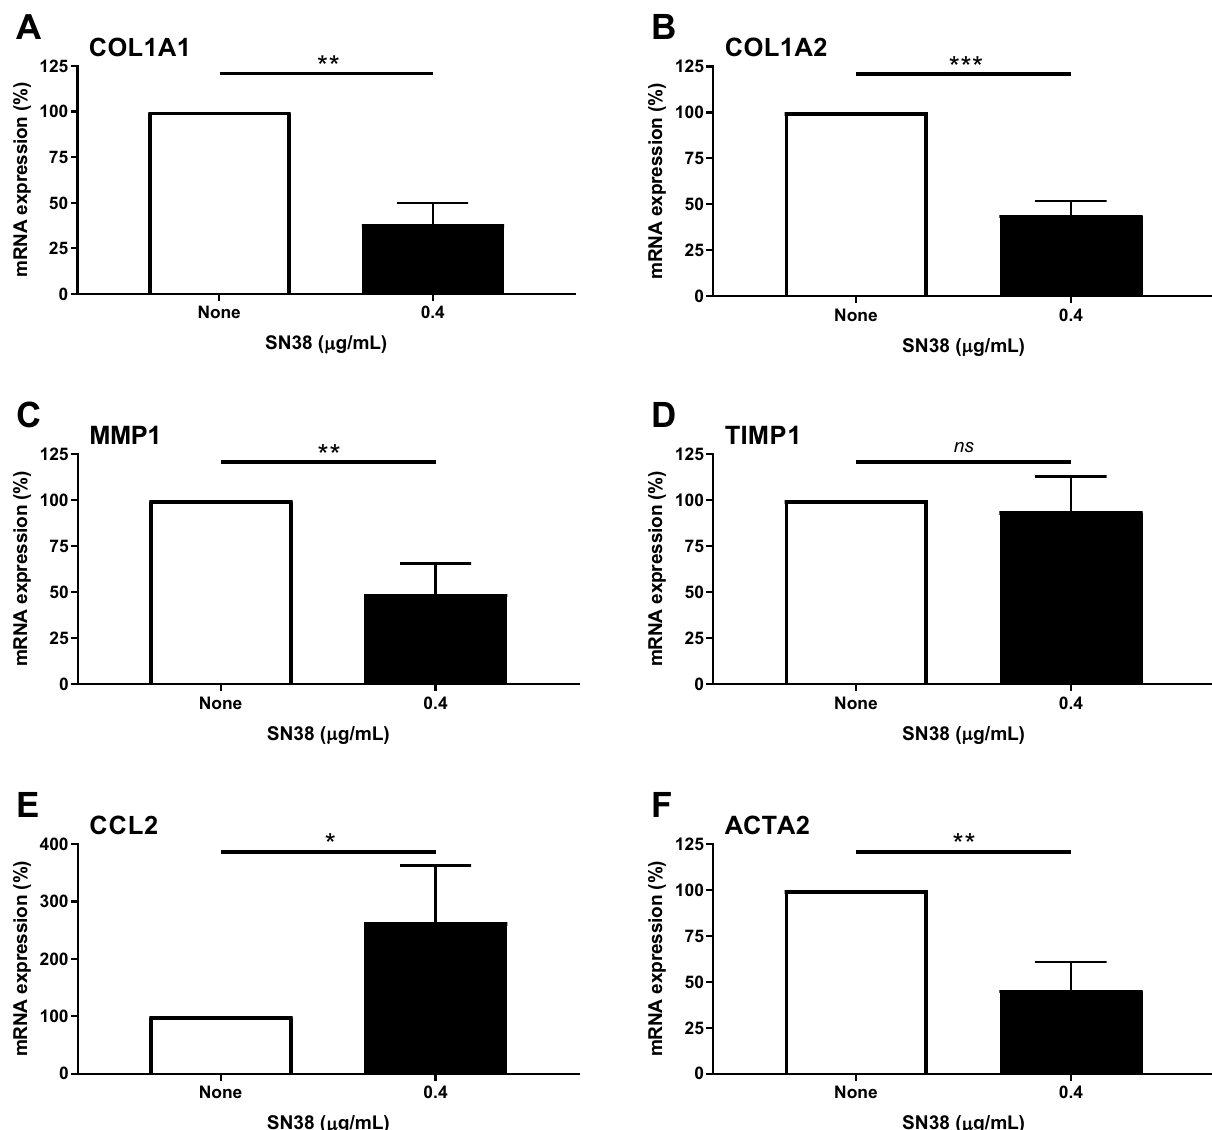
Figure 4. Analysis of SN38 effect on mRNA expression of genes involved in fibrosis in dermal SSc fibroblasts. Relative mRNA expression of a panel of genes involved in fibrosis (from A to F: COL1A1, COL1A2, MMP1, TIMP1, CCL2 and ACTA2) in dermal fibroblasts obtained from 4 systemic sclerosis patients treated with SN38 (0.4 µg/mL), in comparison to a non-treated condition. The non-treated condition was arbitrary fixed at 100%. Analysis of qRT-PCR reactions normalized to stable housekeeping gene GAPDH (Glyceraldehyde-3-phsophate dehydrogenase). A level above 100% corresponds to a gene overexpression in the treated condition and a level below 100% corresponds to a gene downregulation in the treated condition. Mean ± SEM, ns: non significant, * p < 0.05, ** p < 0.01, *** p < 0.001 using paired